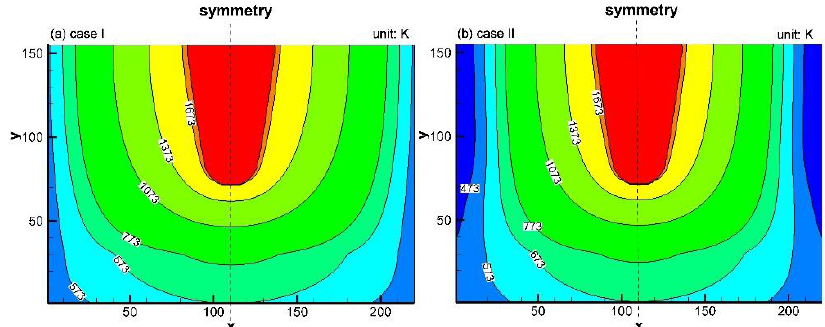
Figure 7. Temperature distribution in the trough materials in the initial stage of a unit campaign cycle: ( a ) without the water cooling device and ( b ) with the water cooling device.